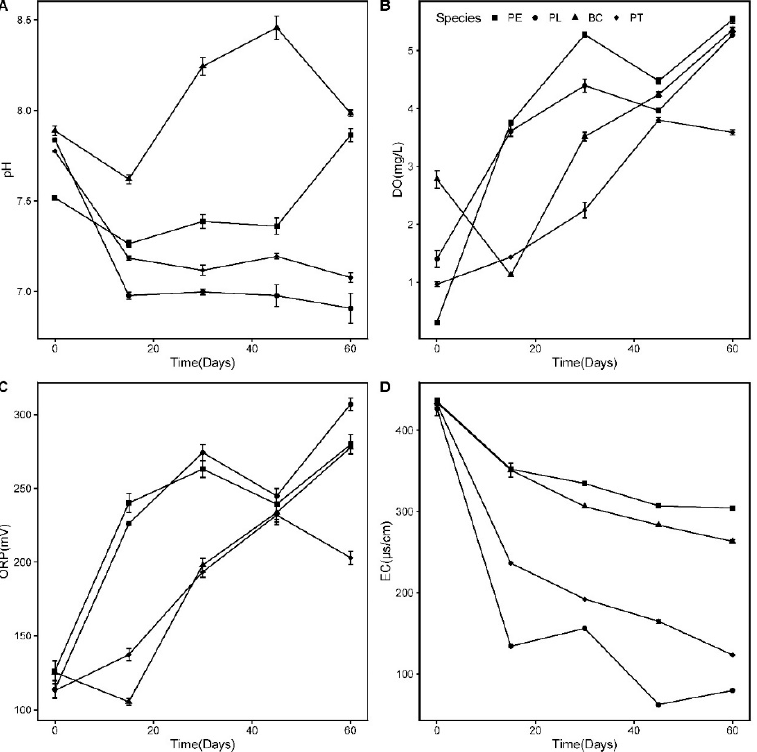
Figure 5. Changes in physical and chemical indicators in wastewater: (PE) E. crassipes ; (PL) L. adscendens ; (BC) black control ; (PT) T. natans (the same in the following figures). ( A ): the value of pH; ( B ): the concentration of DO; ( C ): the value of ORP; ( D ): the value of